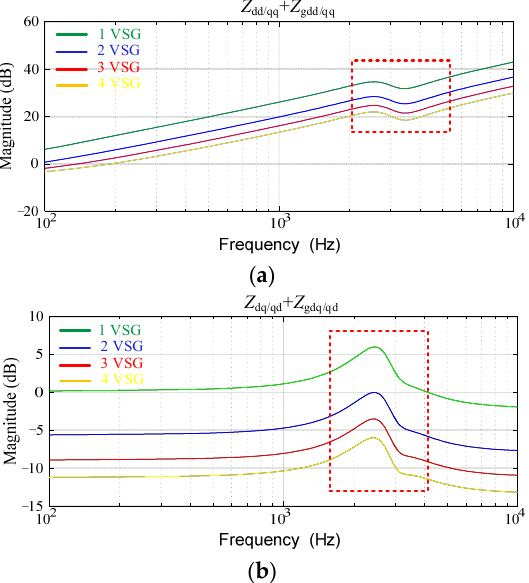
Figure 12. Impedance Bode plots under different paralleled inverters. ( a ) Impedance characteristics on the main diagonal. ( b ) Impedance characteristics on the subdiagonal.